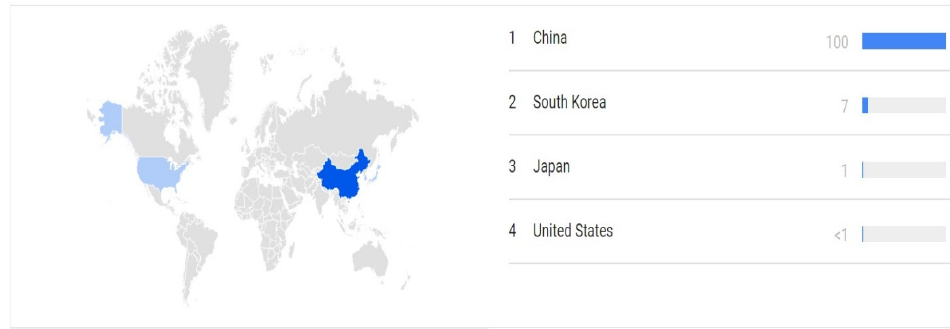
Figure 3. Most Searches DRN.